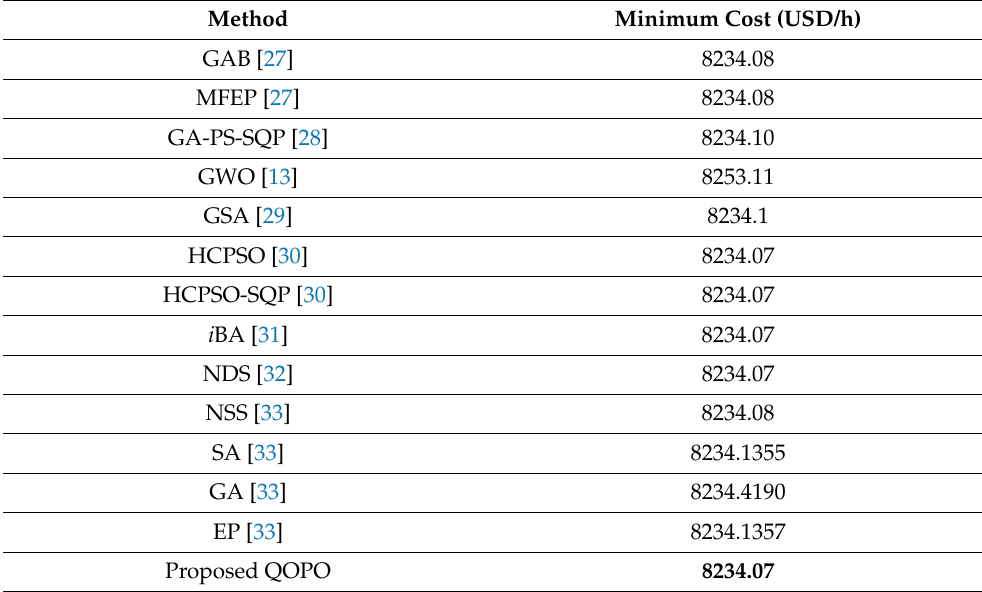
Table 2. Comparison of results of 3-unit system for the load demand of 850